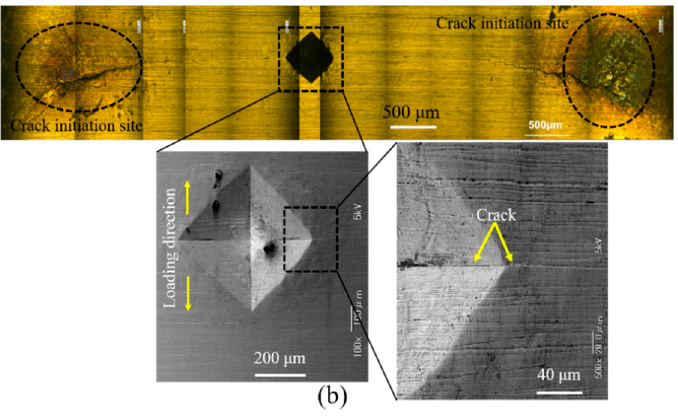
Figure 6. Images of the fatigue cracks on the specimen surface of 20% CW 316L with indents. ( a ) Tested at 380 MPa failed at 2.75 × 10 6 cycles with an indent depth of 45 μ m; ( b ) tested at 400 MPa and failed at 4.65 × 10 5 cycles with an indent depth of 80 μ m.